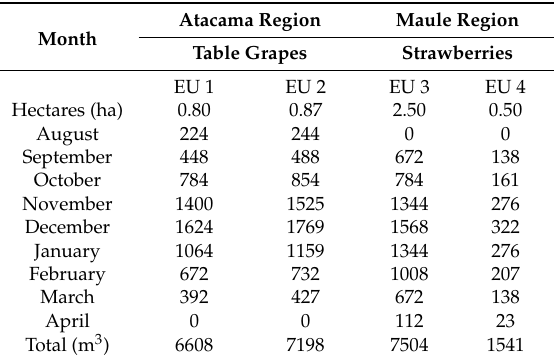
Table 2. Water demand (D) for each EU in m 3